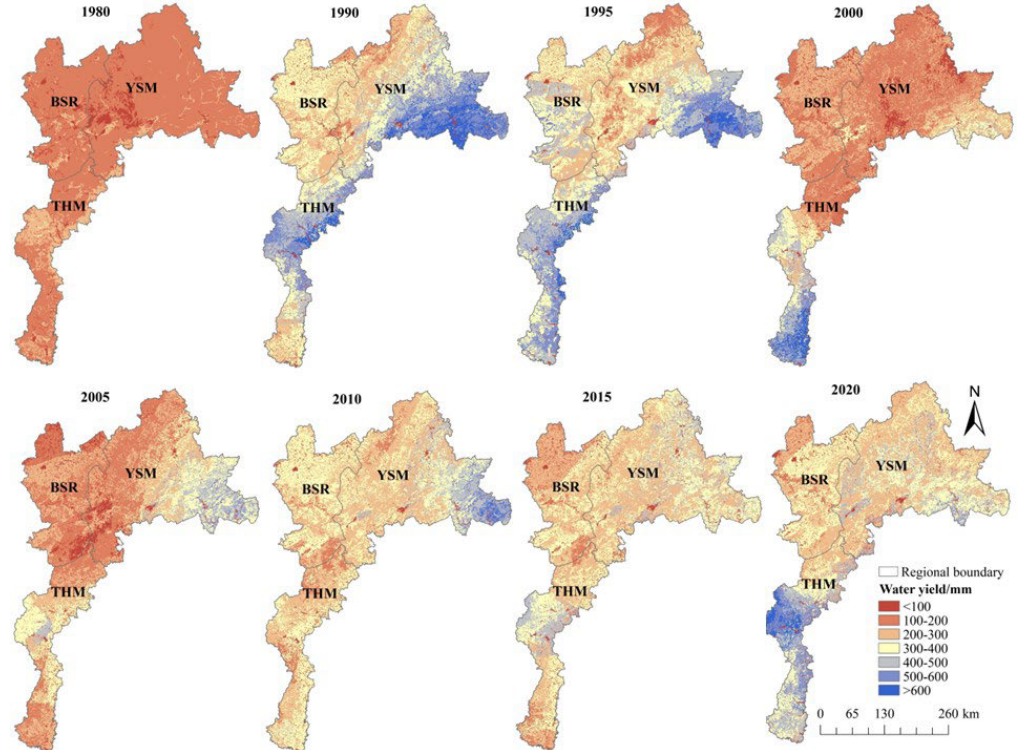
Figure 7. The spatial patterns of water yield in the eight years during 1980–2020 (THM—Taihang Mountain, BSR—Bashang region, YSM—Yanshan Mountain).